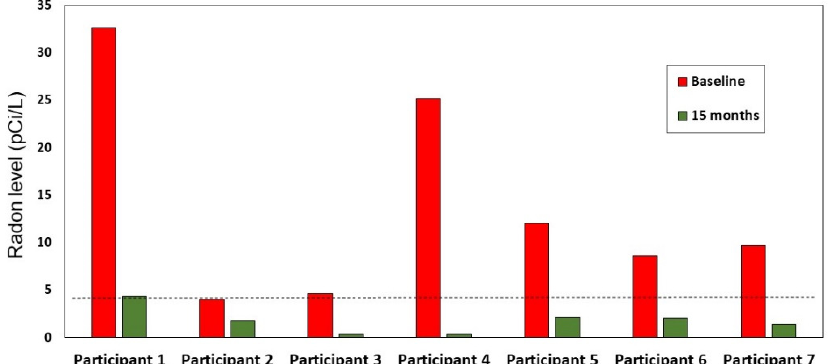
Figure 3. Mitigation radon values at baseline and follow up for the participants who reported